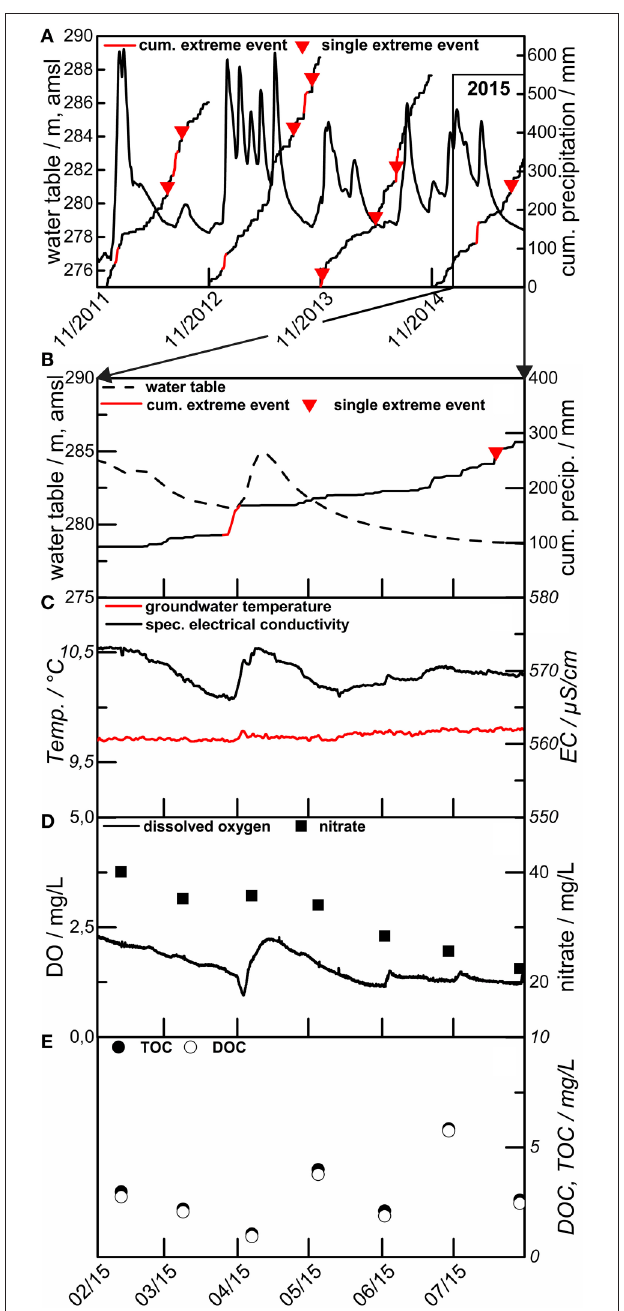
FIGURE 7 | Example hydrograph, precipitation and groundwater level for the years 2011 to 2015 (A) at site H3, HTU. Detail of the year 2015, showing water table and precipitation (B) , water temperature and el. conductivity (C) , dissolved oxygen (DO) and nitrate (D) , and total and dissolved organic carbon (TOC/DOC) (E) .